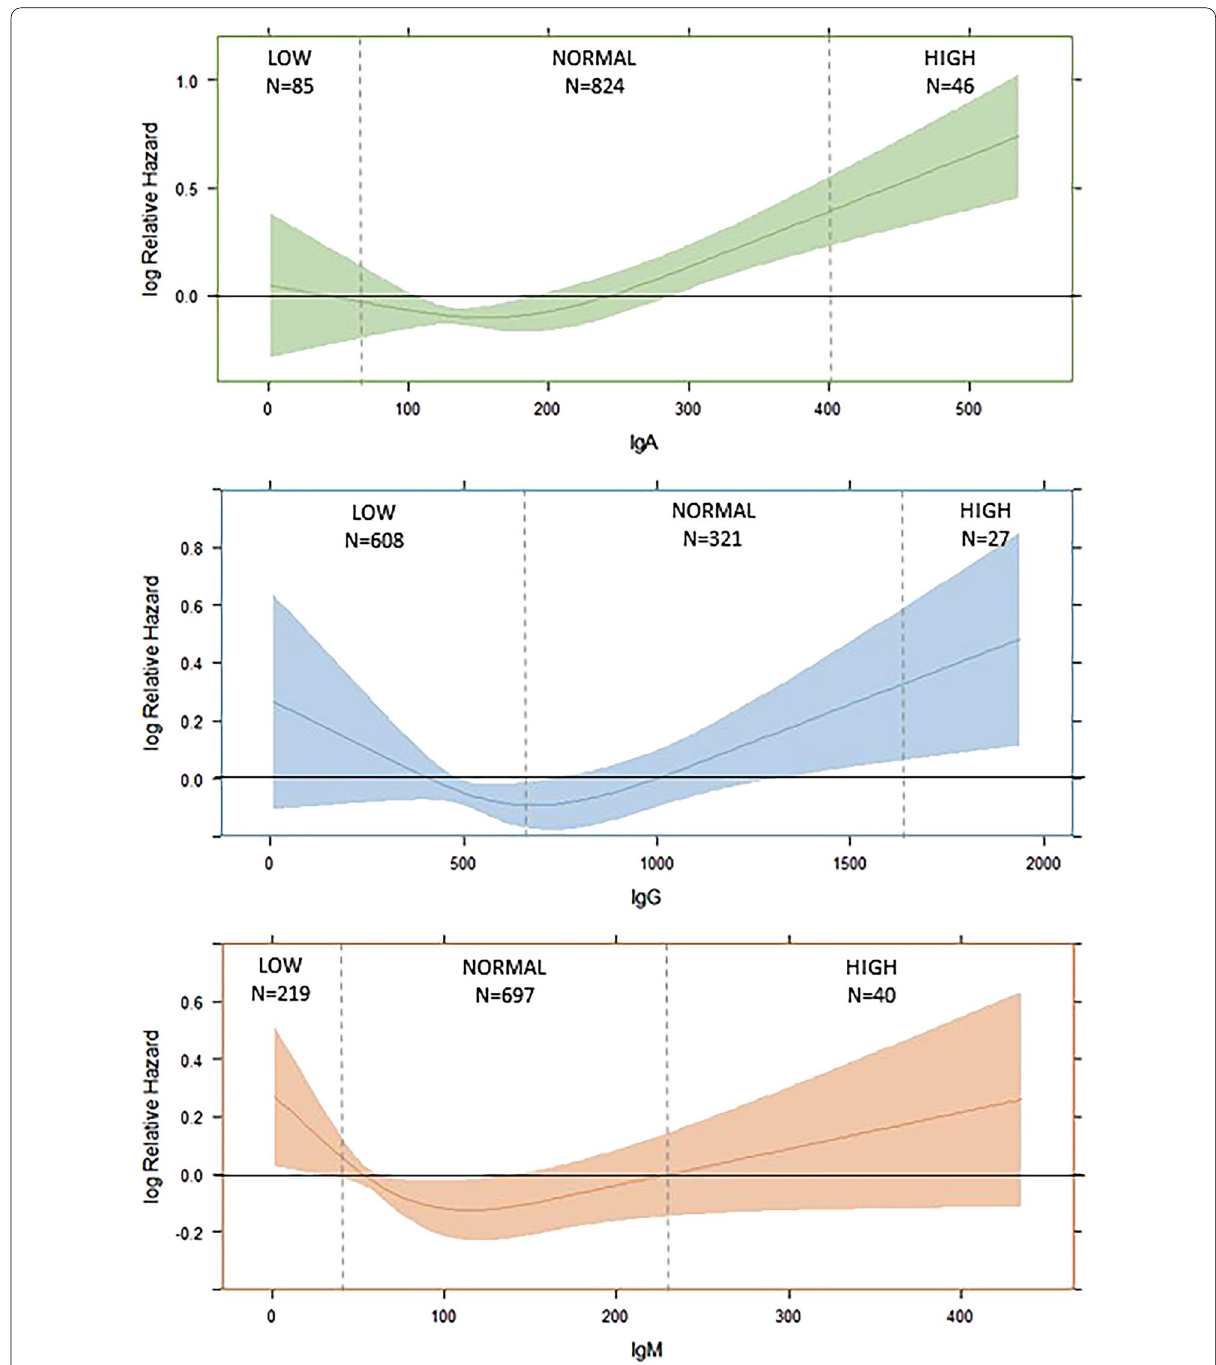
Fig. 1 Splines for 90-day mortality, dotted line represents the inflection